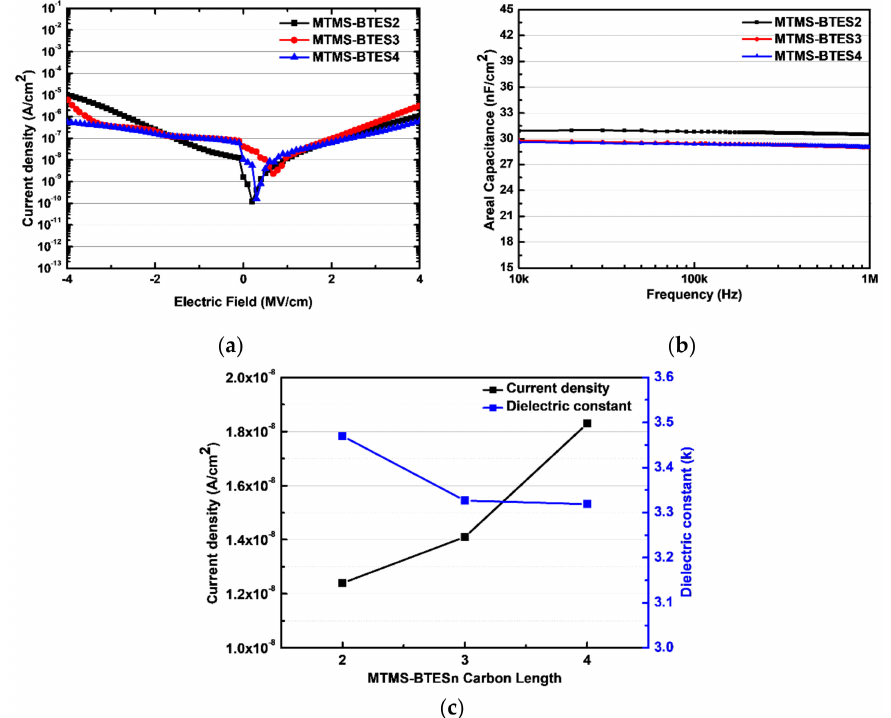
Figure 3. Electrical properties of spin-coated copolymer films fabricated with various monomers (thickness: 100 nm): ( a ) Leakage current density vs electric field plot; ( b ) Capacitance-frequency plots (10–10 3 kHz); ( c ) Comparison of leakage current density and k value as a function of monomer